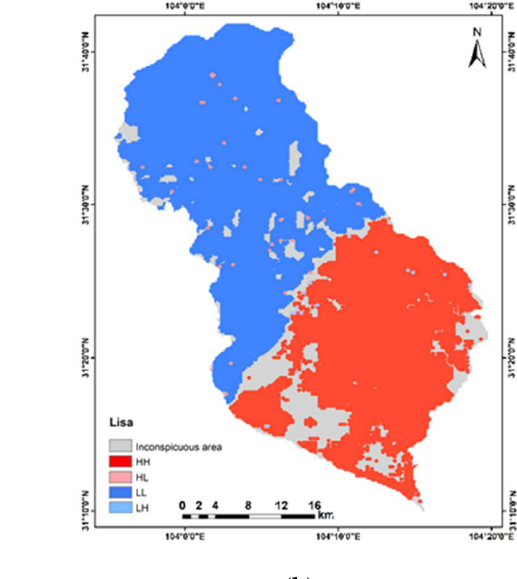
Figure 7. Distribution of townships disturbed by human activity.